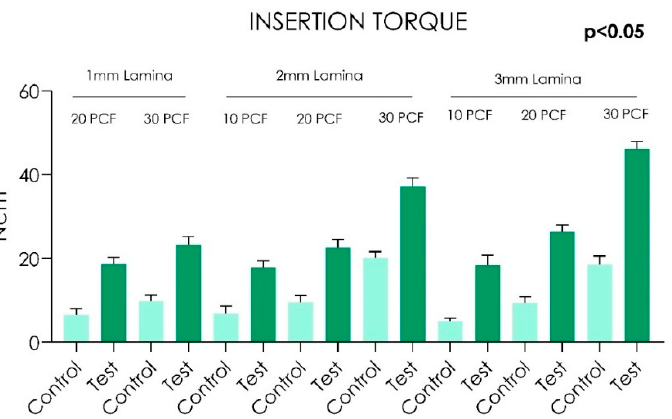
Figure 6. Insertion Torque Values for Test Implants and Control Implants in different polyurethane block conditions.